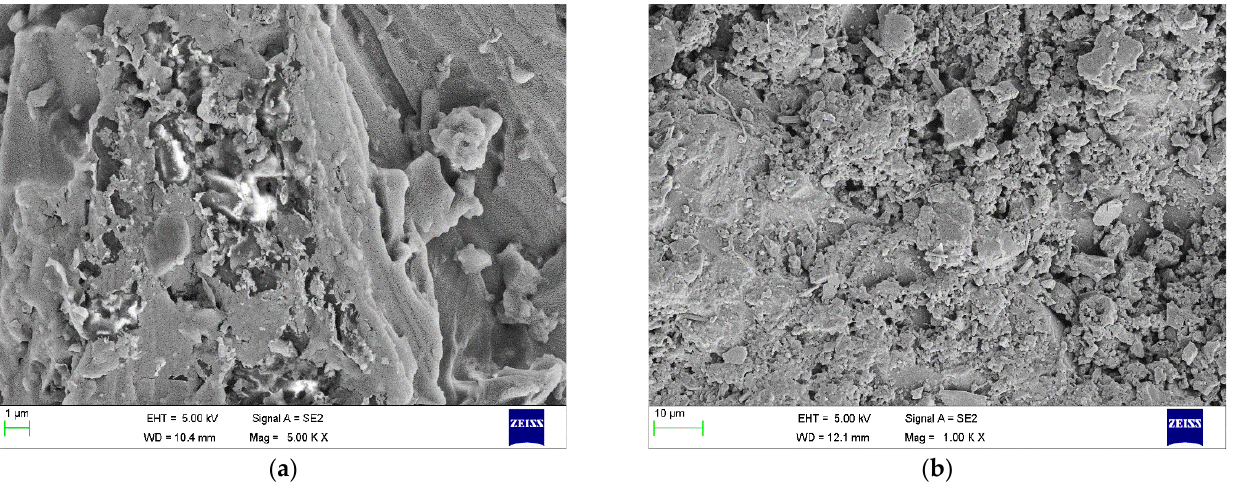
Figure 9. Patterns of nanocomposites with different reinforcement ( a ) 0.5 wt % ( b ) 0.6 wt % of GNP and h-BN.